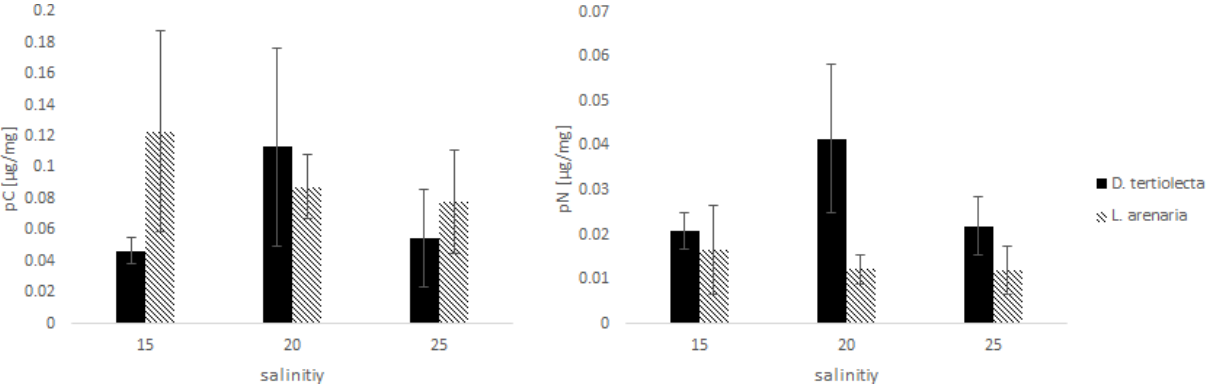
Figure 3. The uptake of C (pC) and N (pN) from different food sources (the green algae D. tertiolecta and the diatom L. arenaria ) by E. excavatum after 5d at 20 ◦ C and a light–dark cycle of 16 :